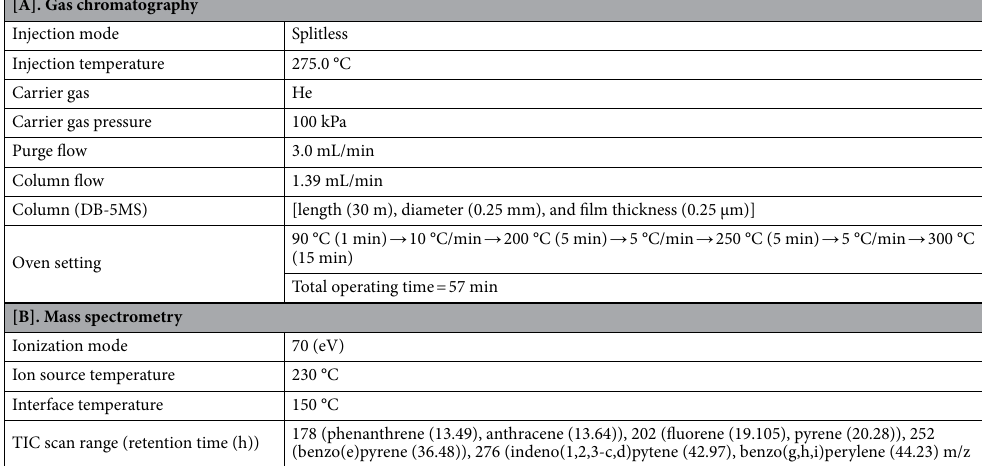
Table 4. Operational conditions for analyzing particulate PAHs. PAHs polycyclic aromatic